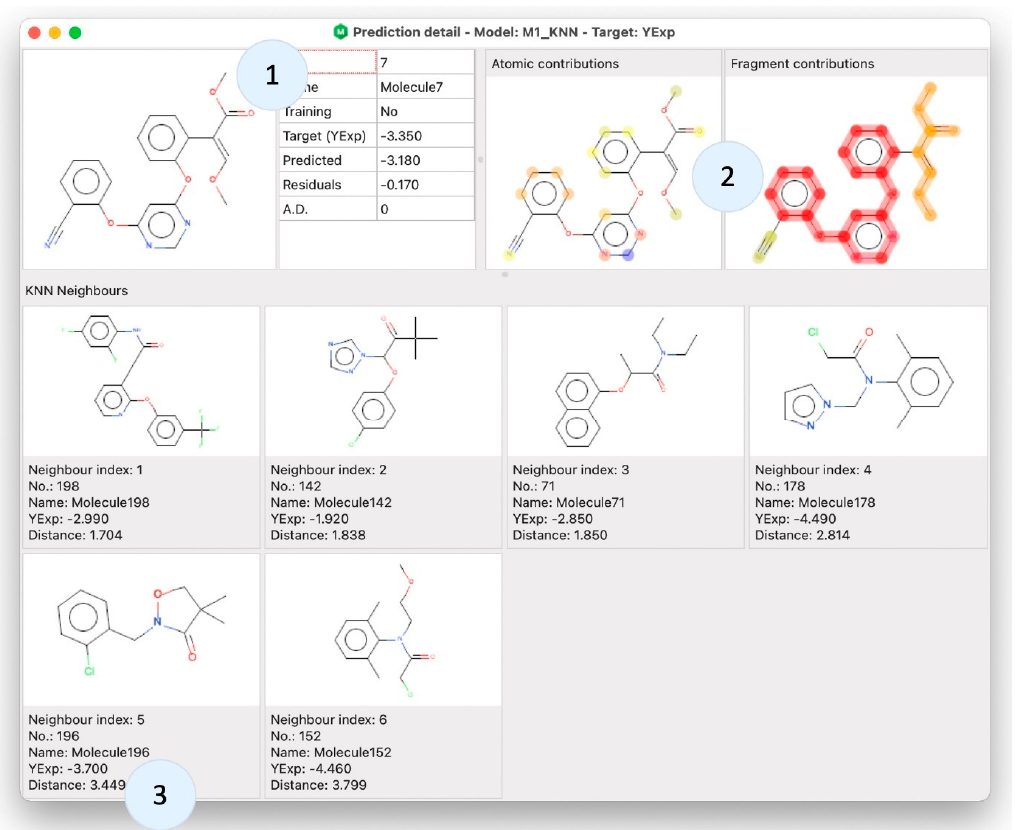
Figure 5. Prediction detail window comprises three sections. The first one (1) shows the target in- formation, the second one (2) includes the atomic and fragment contributions and the third one